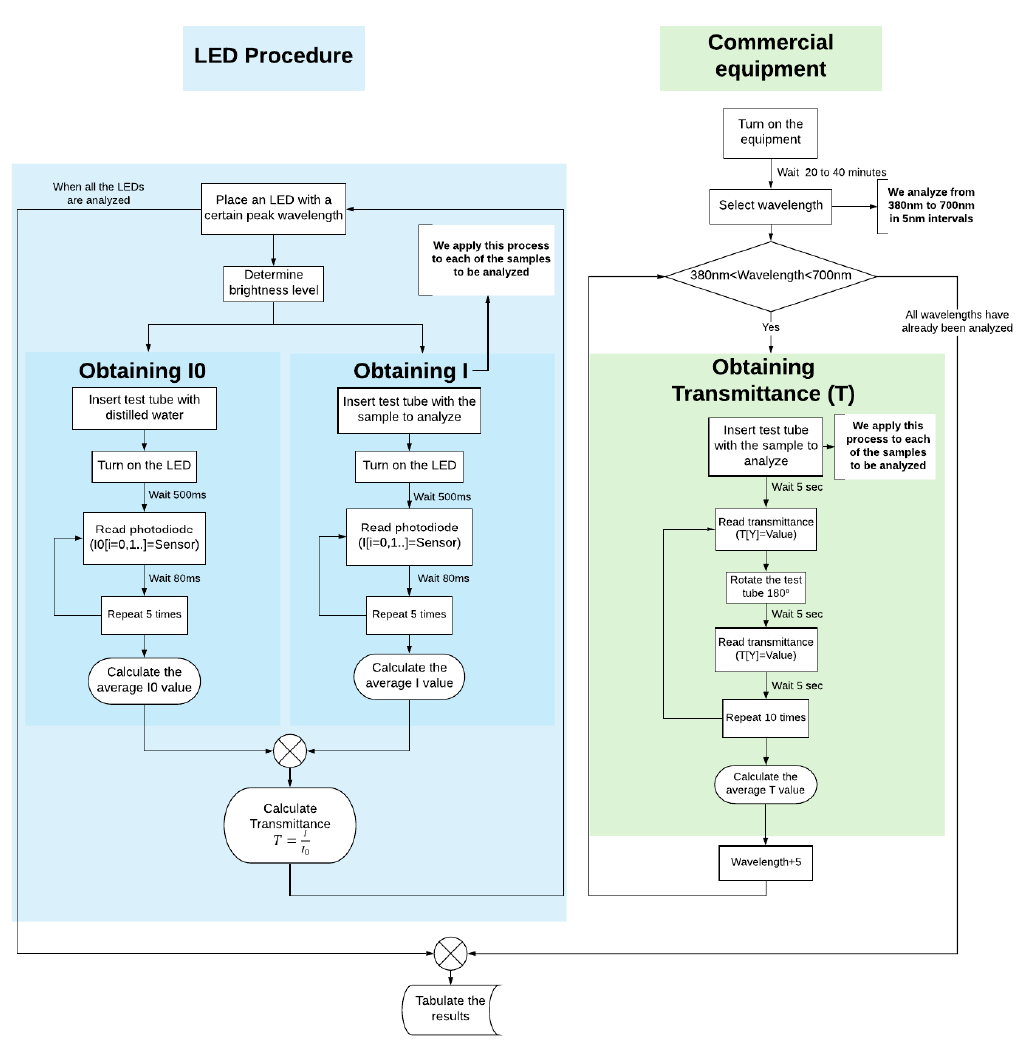
Figure 6. Scheme of the work methodology.